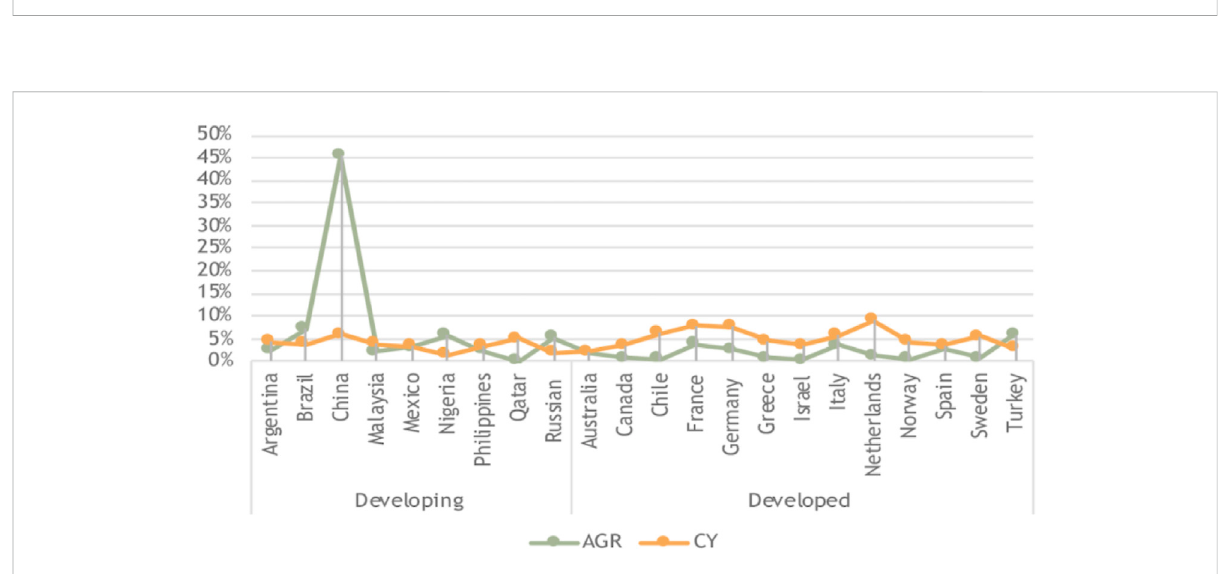
FIGURE 2 Carbon emissions with agriculture and cereal